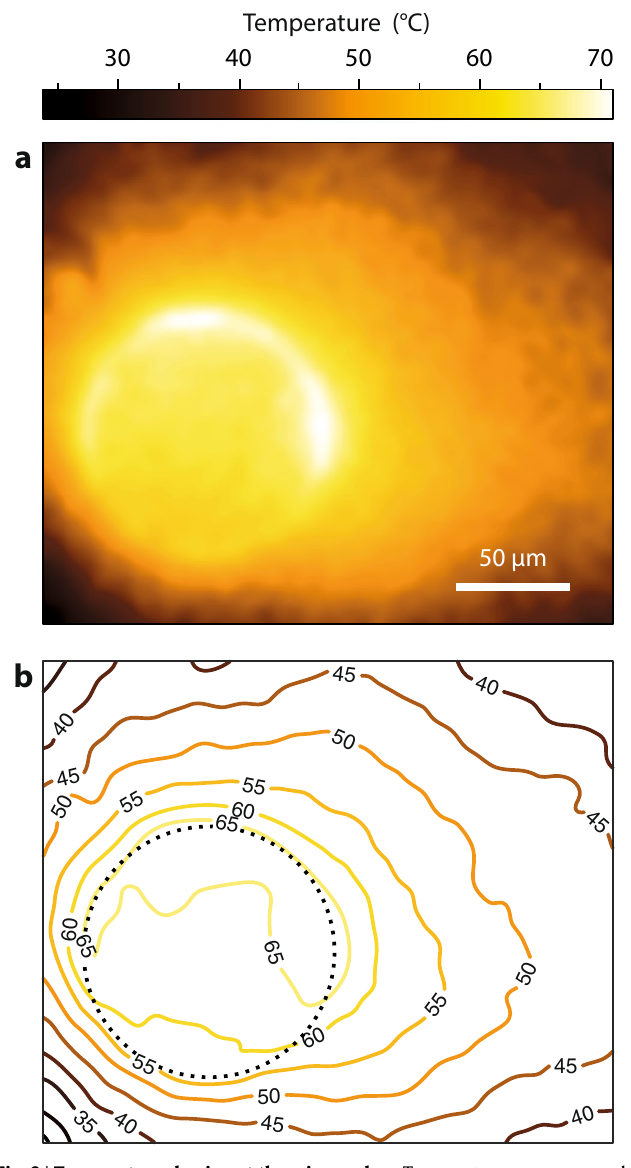
Fig. 2 | Temperature shaping at the microscale. a Temperature map measured using CGM obtained when illuminating a gold nanoparticle layer with a ring-like laser beam to obtain a fl at temperature pro fi le over a circular area. b Isotherms of the temperature map ( a ). The outline of the laser beam is represented by a grey, dotted circle. Experiment repeated twice (see Supplementary Materials, Fig.